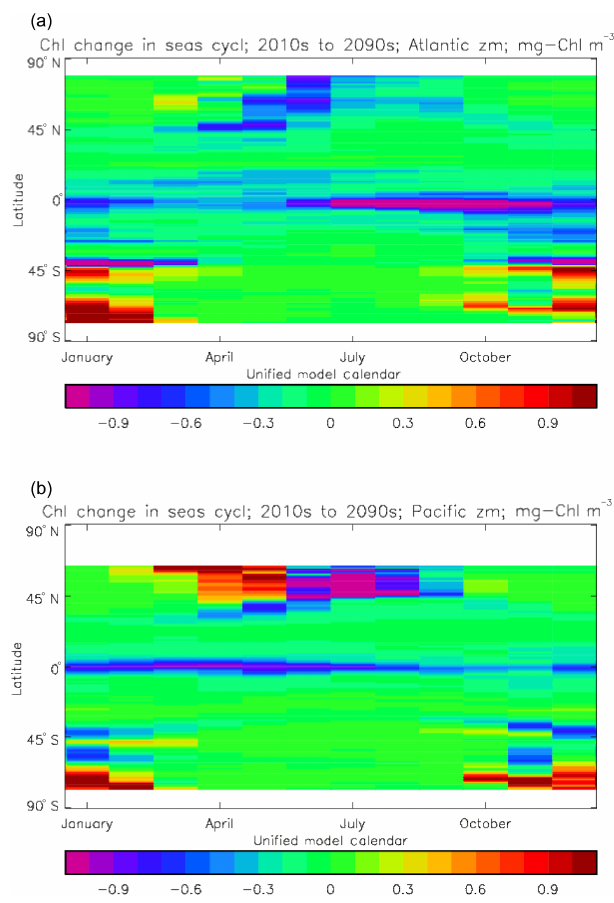
Figure 36. Change in the seasonal cycle of surface chlorophyll con- centration in the CMIP5 RCP8.5 simulation: change is calculated between the mean seasonal cycles of the model years 2090–2099 and 2010–2019. Zonal means of the (a) Atlantic Ocean basin and (b) Pacific Ocean